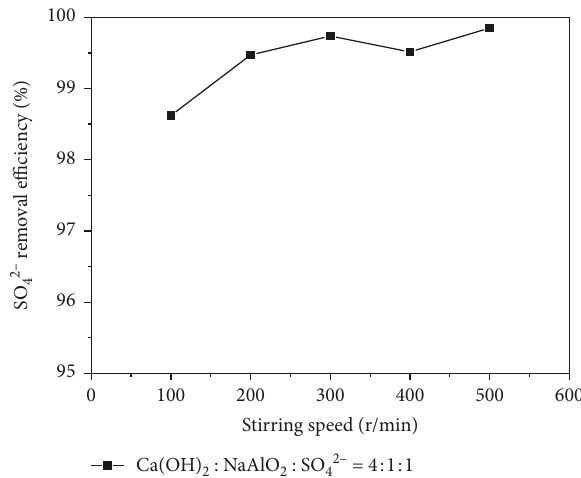
Figure 6: The effect of stirring speed. V 7.0. Figure 7: The effect of T 25 ° C, and pH (cid:27) (cid:27)